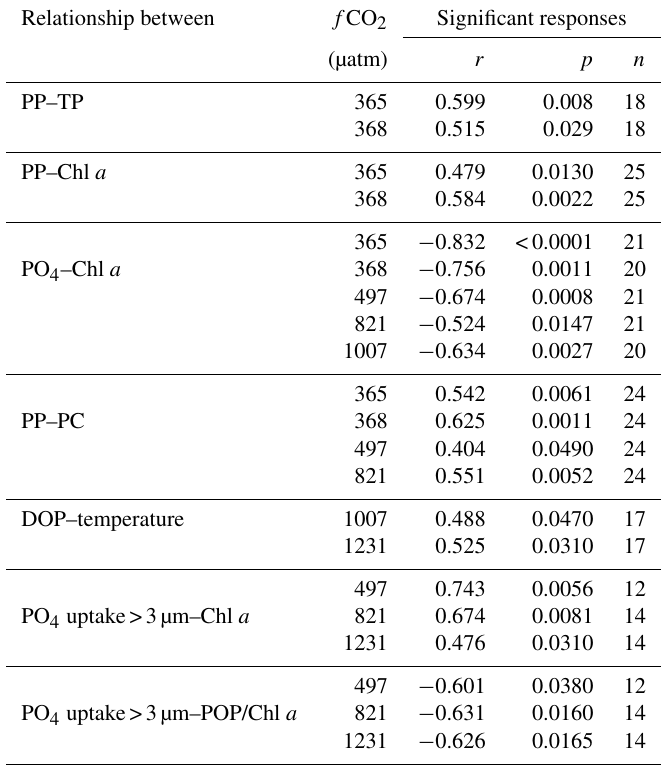
Table 2. Mesocosms in which the Spearman Rank correlation between P-pools or uptake rates and other parameters was significant. The relationship of PP with TP and Chl a was significant only in the untreated mesocosms while the correlation to PC was also significant in the mesocosms with intermediate CO 2 levels. DOP was related to temperature only in the high CO 2 treatments. Under high f CO 2 conditions, the PO 4 uptake in the size fraction >3µm correlated with Chl a and the P content of phytoplankton.